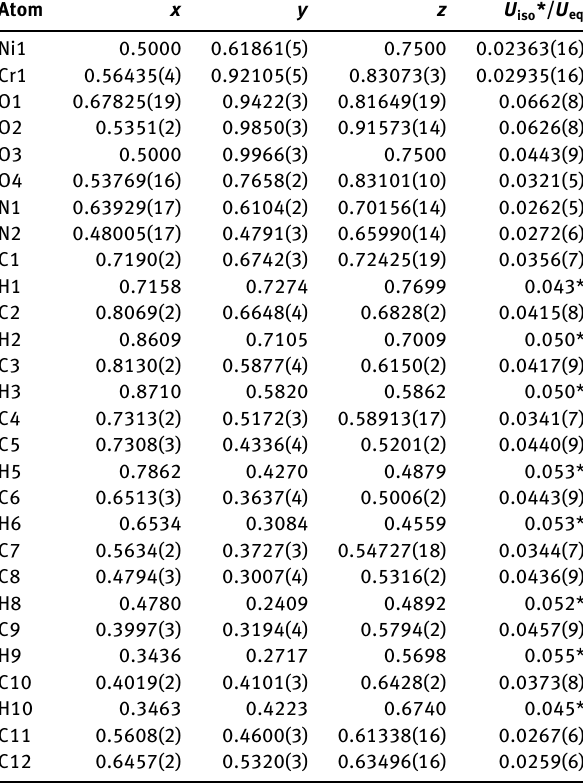
Table 2: Fractional atomic coordinates and isotropic or equivalent isotropic displacement parameters (Å 2